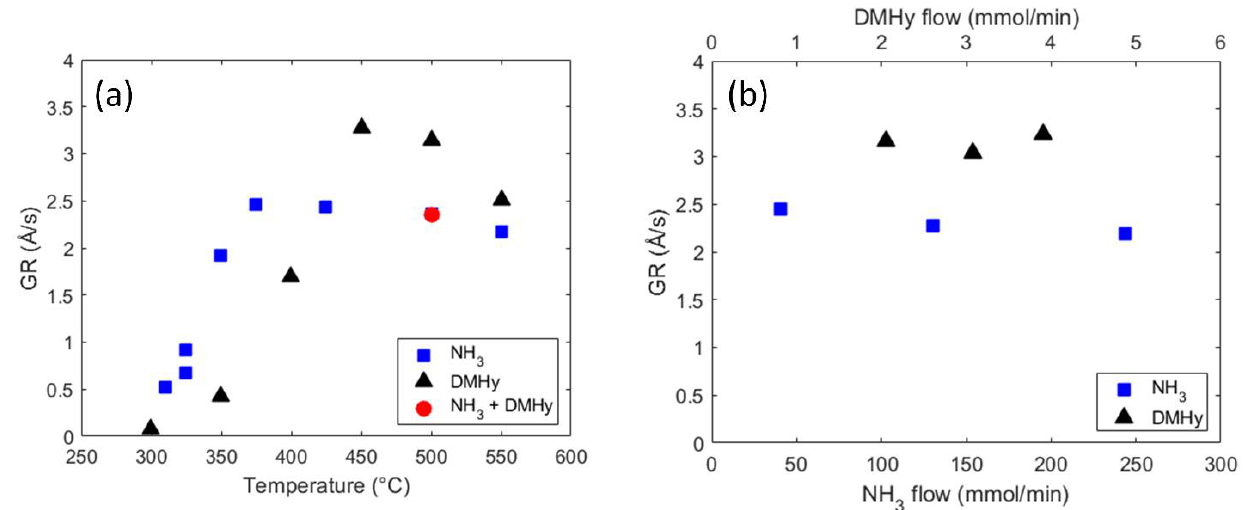
Figure 4. GR calibrations for AlN grown with TMAl (9.4 μmol/min) and either NH 3 , DMHy, or both precursors. ( a ) GR versus temperature for 143 mmol/min NH 3 , 3.9 mmol/min DMHy, and one point for 143 mmol/min NH 3 + 3.9 mmol/min DMHy. ( b ) GR versus N-precursor flow at 500 °C with the DMHy flow given off the top x-axis.